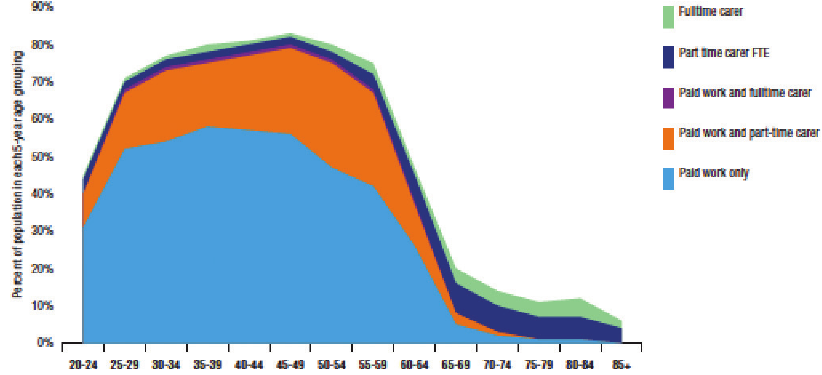
gal, Slovenia, Spain, Sweden, Switzerland and United Kingdom. The group “Paid work and fulltime carer” is unfortunately not visible in black and white graphics, but it is much smaller than the other groups and primarily exists in the age groups from 30 to 60. For details, please see the original source ( Source : Cylus et al. 2018: 20)